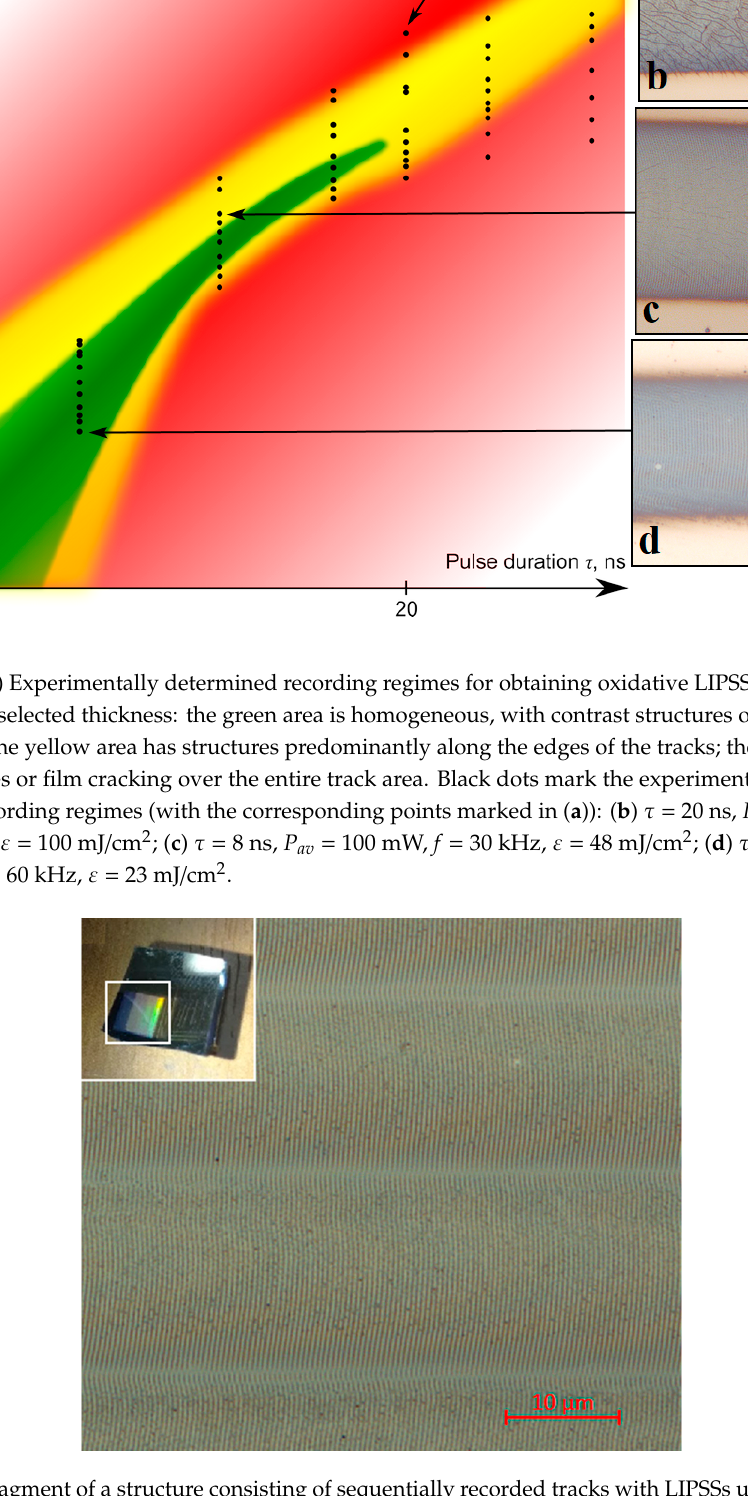
Figure 5. Fragment of a structure consisting of sequentially recorded tracks with LIPSSs using an initial partially polarized laser beam. Recording regime: τ = 4 ns, P av = 90 mW, f = 50 kHz, ε = 20 mJ/cm 2 (for a single track see Figure 2a). Sample photo is shown in the inset.